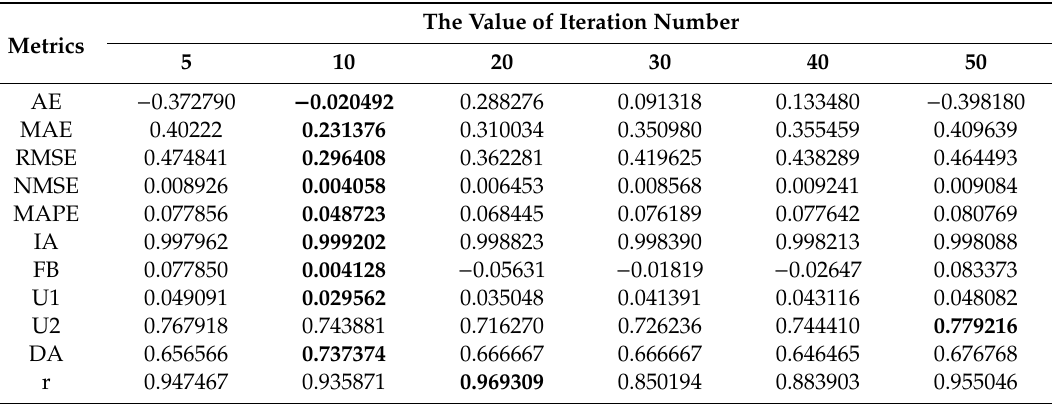
Table 15. Sensitivity analysis of the di ff erent iteration numbers based on